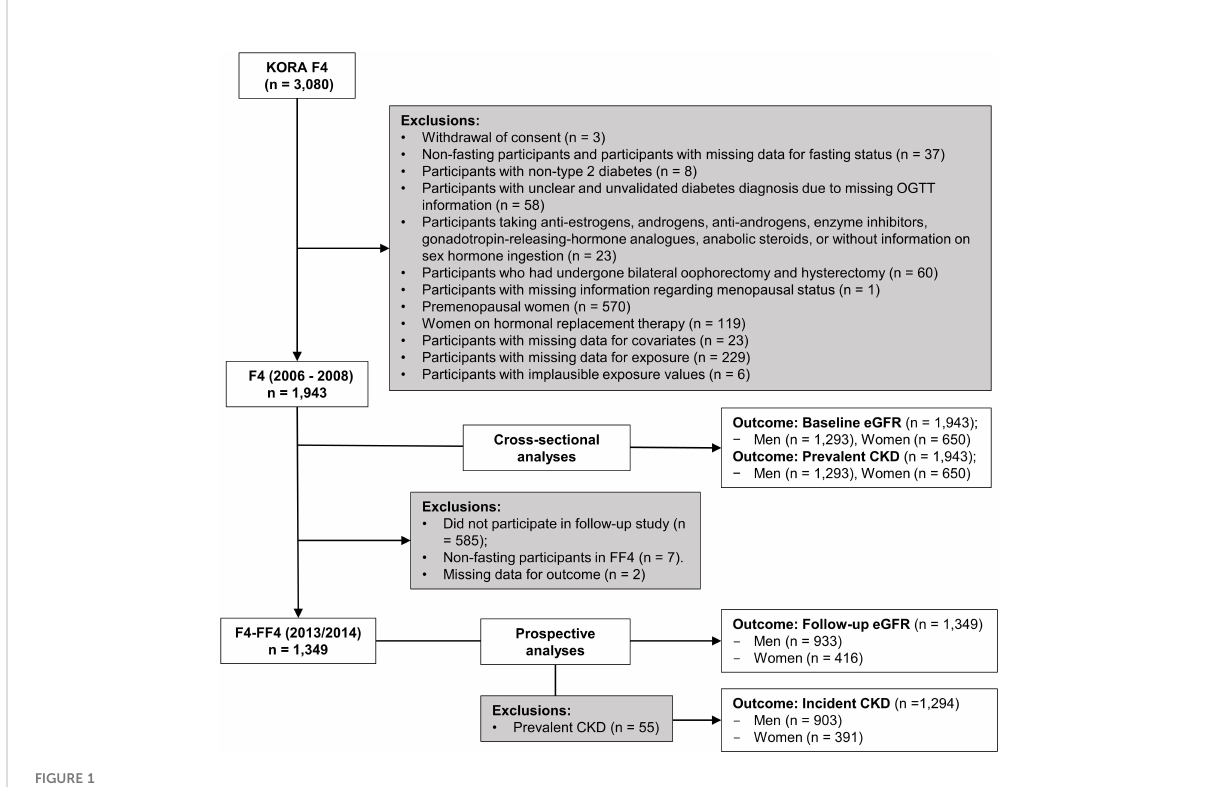
FIGURE 1 Exclusion fl